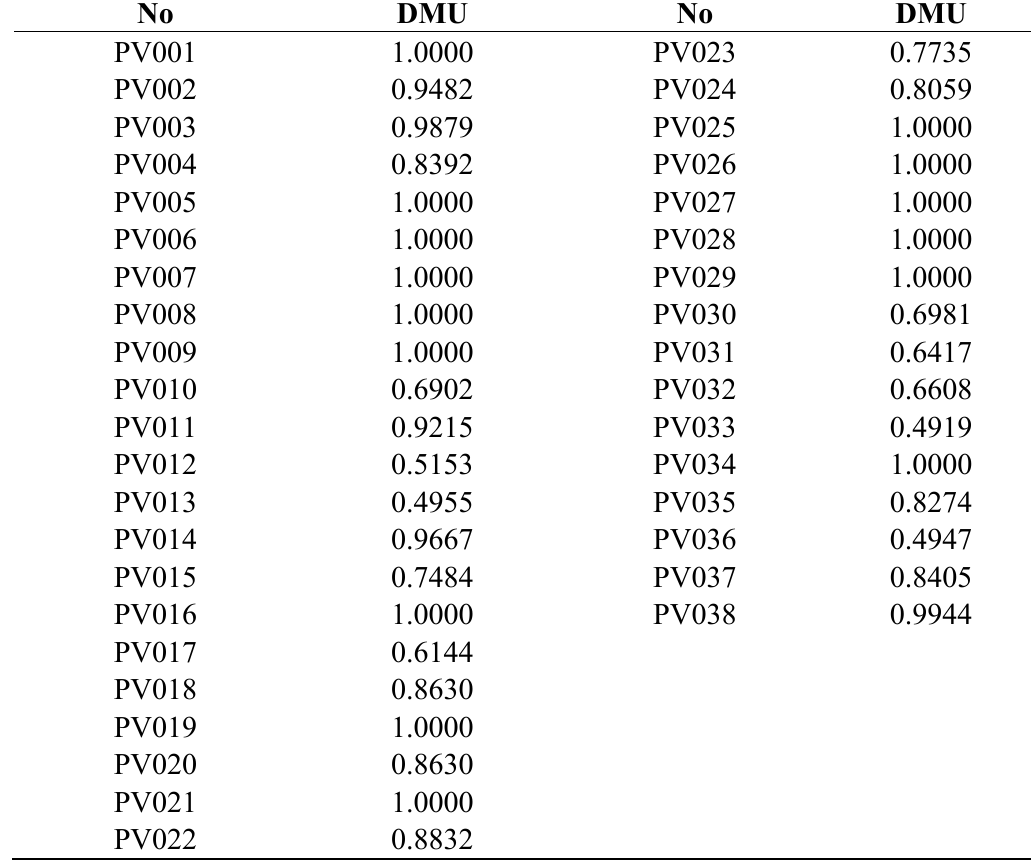
Table 3. The results of DMU value of each PV system by utilizing